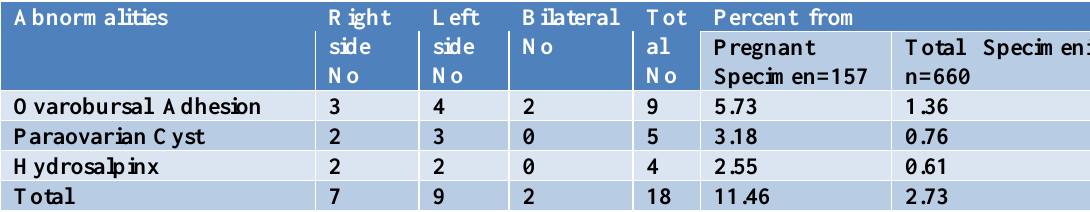
Table, 1: Gross abnormalities in pregnant genitalia of Iraqi ewes.